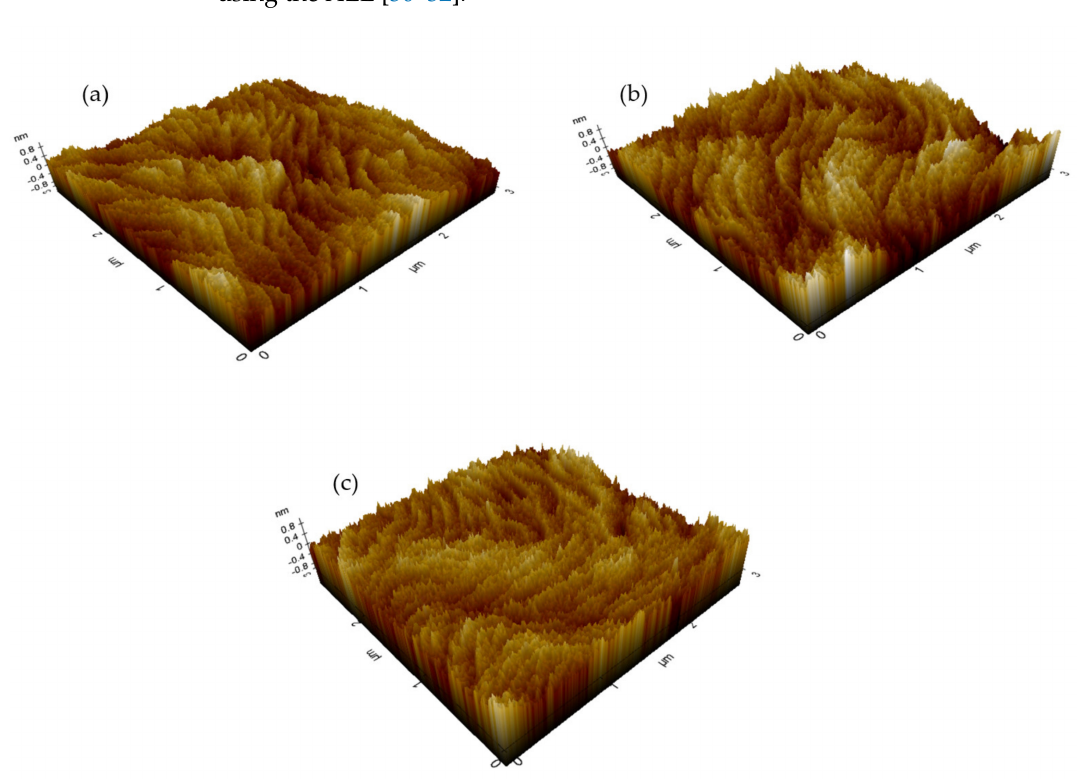
Figure 11. Atomic force microscopy (AFM) images of the surfaces etched using ( a ) ALE and ( b ) digital etching and ( c ) the as-grown surface before